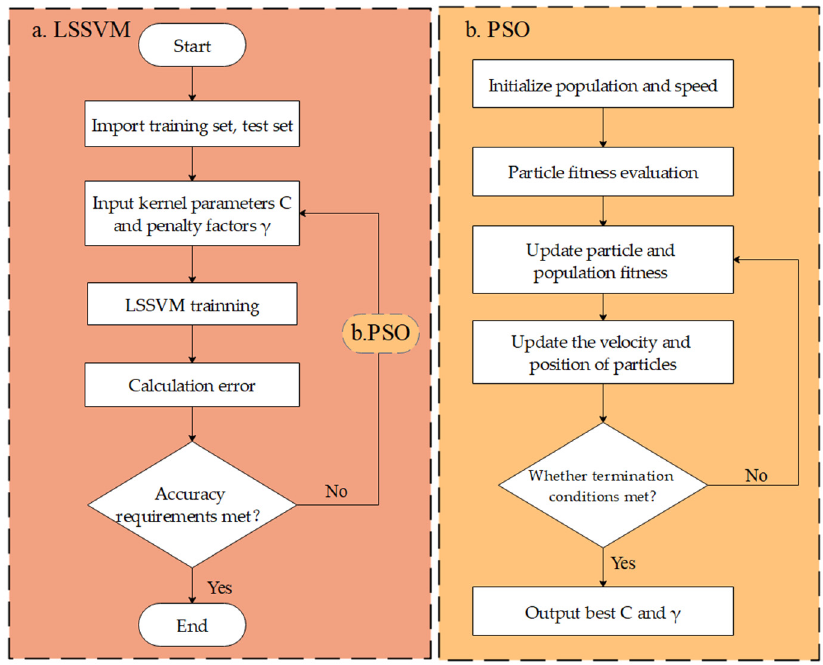
Figure 1. The flow chart of the combination algorithm.